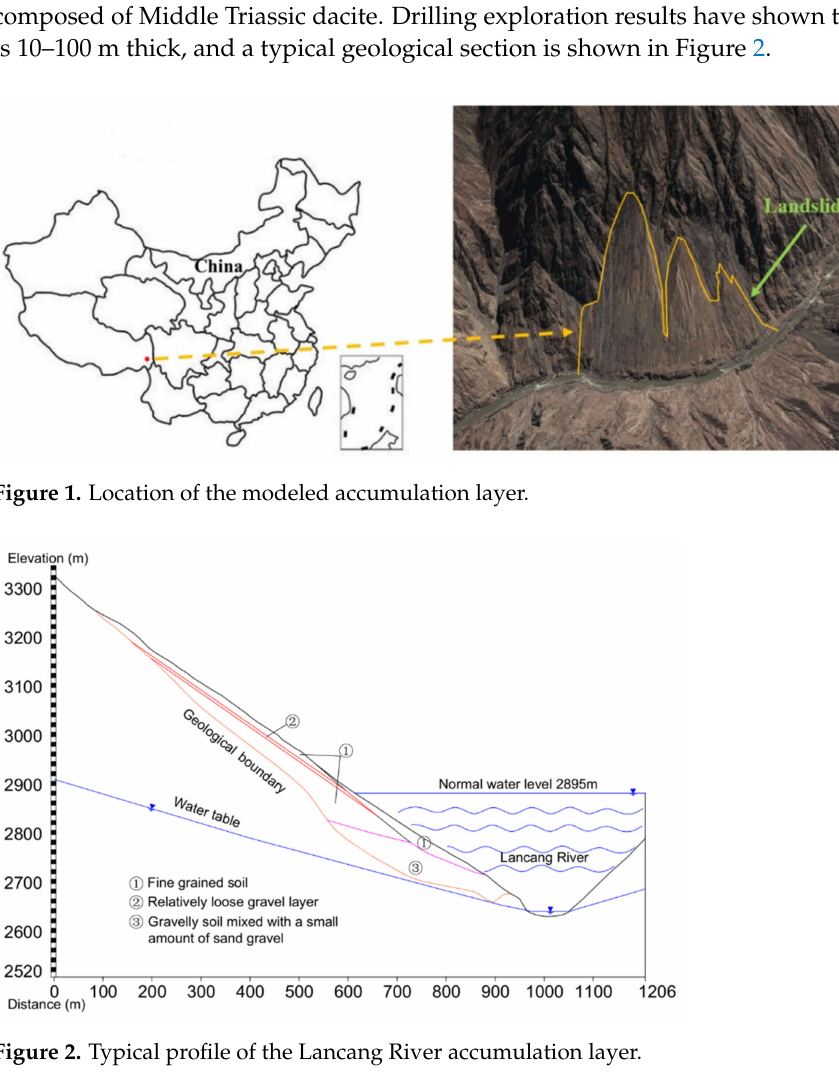
Figure 2. Typical profile of the Lancang River accumulation